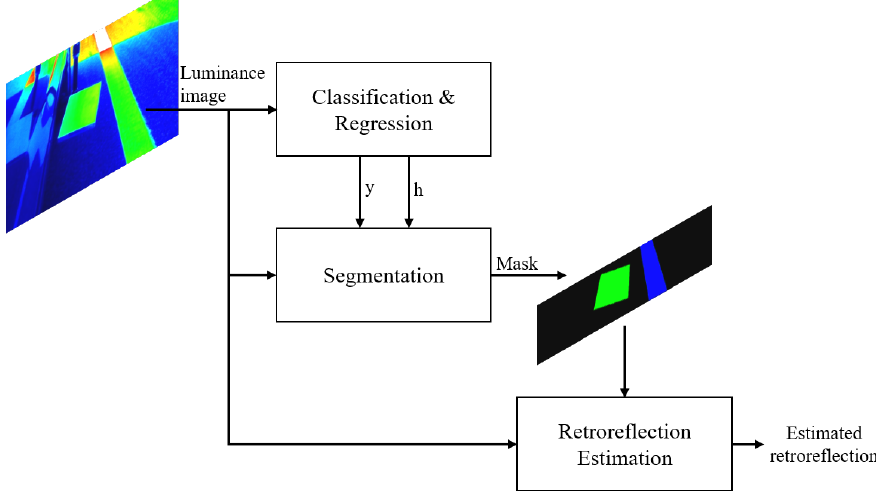
Figure 2. Proposed framework for dynamic retroreflection